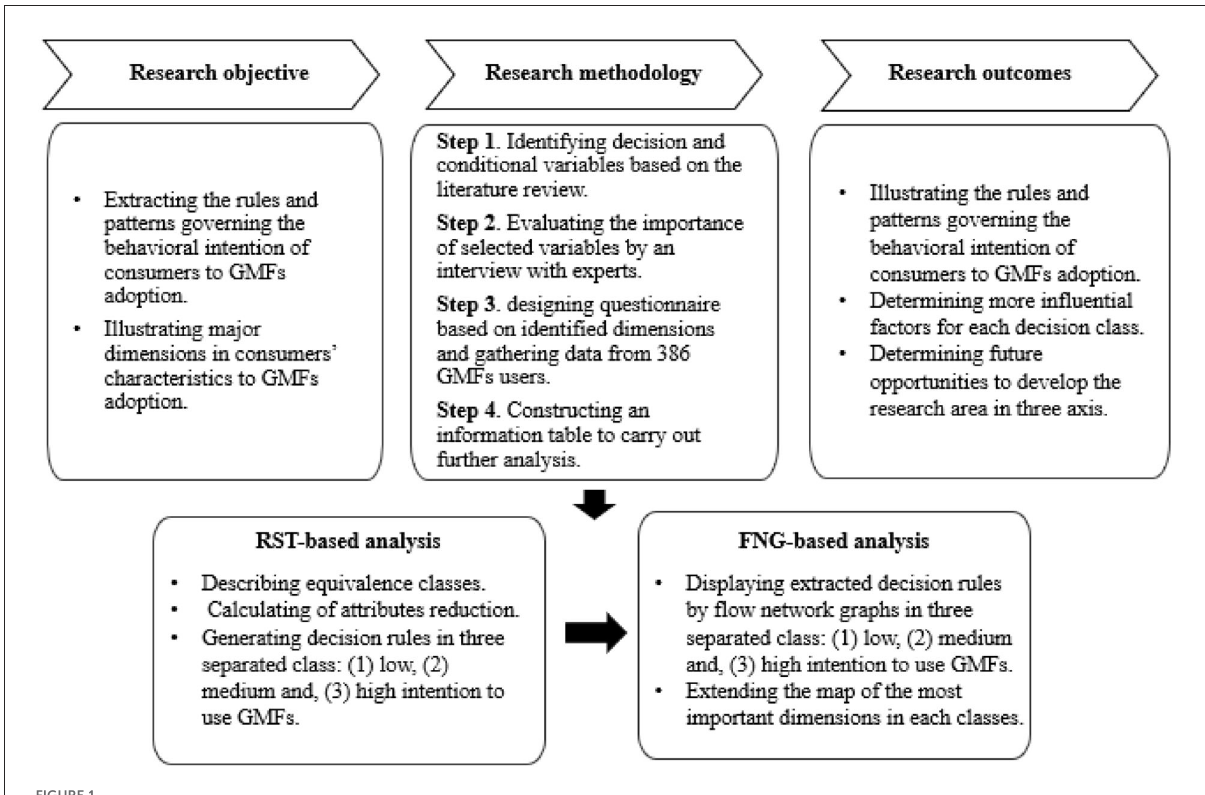
FIGURE1 Research design (authors’